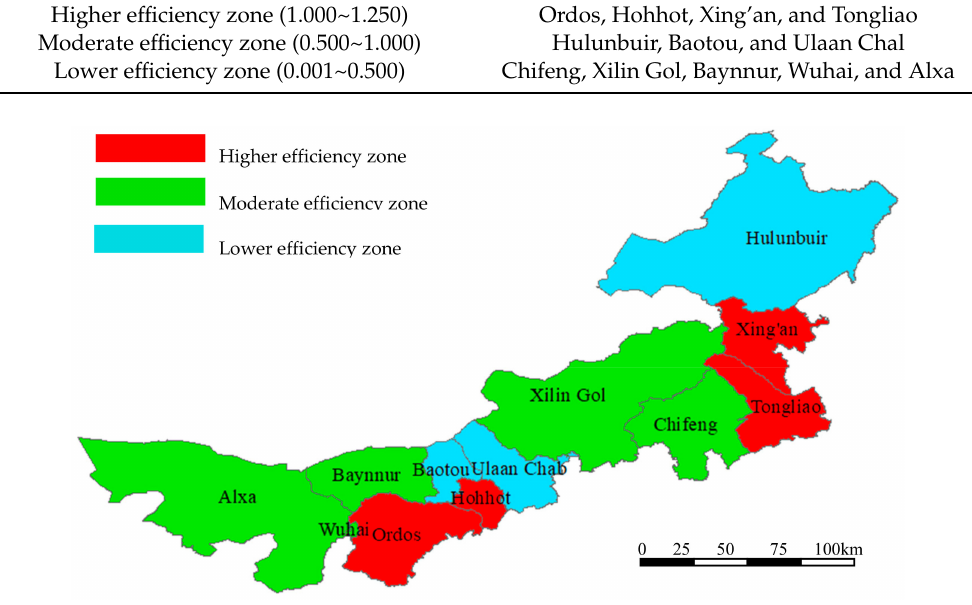
Figure 2. The location of di ff erent e ffi ciency zones on the map of Inner